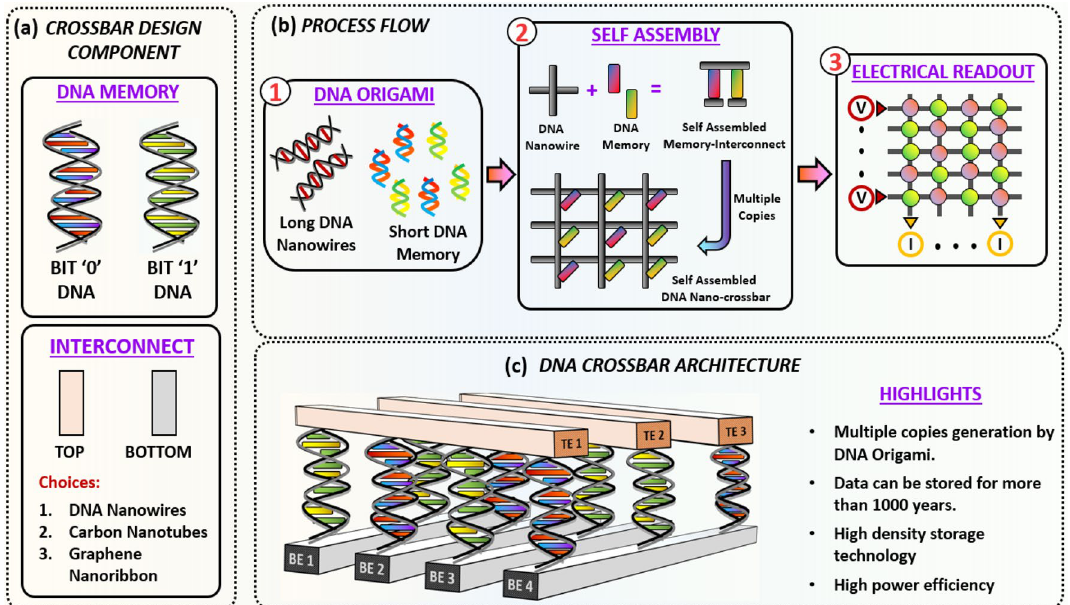
Figure 1. Illustration of a DNA based nanosystem for high-density data storage. ( a ) DNA crossbar components including memory cells and interconnects. ( b ) Process flow for the proposed technology. DNA origami